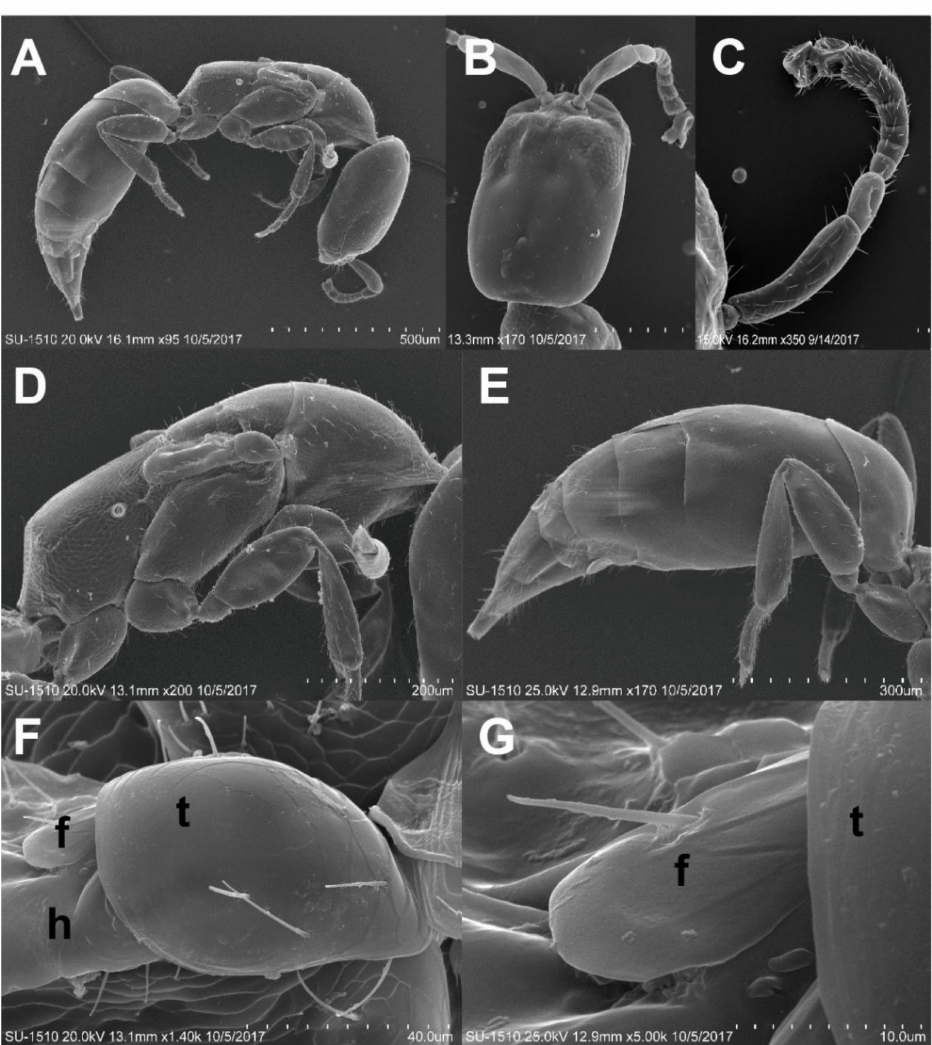
Figure 5. Brachypterous adult female of Cephalonomia formosiensis sp. nov. ( A ) Habitus, lateral view. ( B ) Head, dorsal view. ( C ) Antenna. ( D ) Mesosoma, lateral view. ( E ) Metasoma, lateral view. ( F ) Tegula, lateral view. ( G ) Wing, lateral view (t = tegula, f = forewing, h = hindwing). Mesosoma wider than that of female (Figure 6F), 1.83 times as wide as WPD. Pronotal disc trapezoidal, wider than long, 0.34 times as long as wide, with slightly convex anterior margin and straight posterior margin in dorsal view; anterolateral corner forming dull angle; surface smooth and shining. Mesoscutum smooth and shining; dorsal disc as wide as WPD; notauli absent; parapsidal furrows shallow and weak; scutellum smooth and shining, as long as mesoscutum; scutellar pits rectangular, separated by separated by 0.5 times their own lengths. Metanotum distinct, 0.3 times as long as mesonotum, scutellum and propodeum separated medially; surface smooth and shining. Mesopleuron smooth and shining; upper portion with a longitudinal fovea. Propodeum microreticulate including declivity surface and lateral surfaces; dorsal disc rectangular, as long as wide, with parallel sides and weakly concave posterior margin; lateral carinae present, but transverse carina